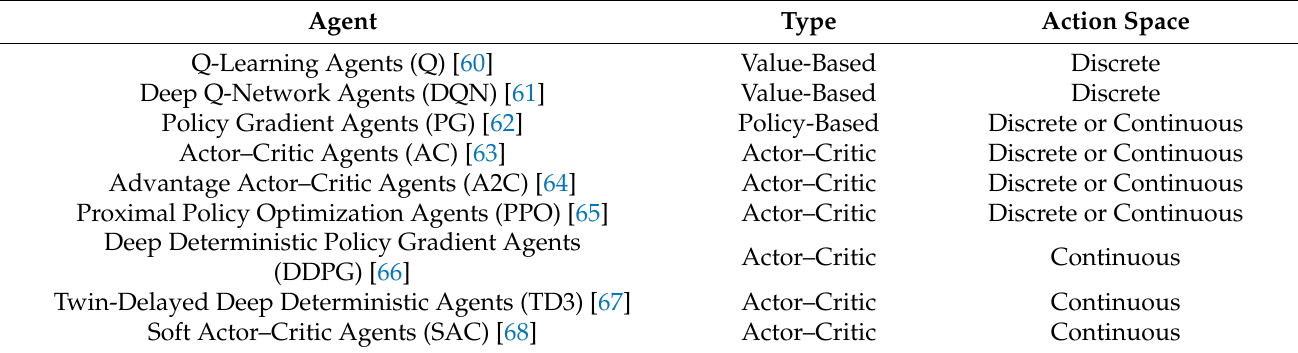
Table 1. State-of-the-art model-free RL